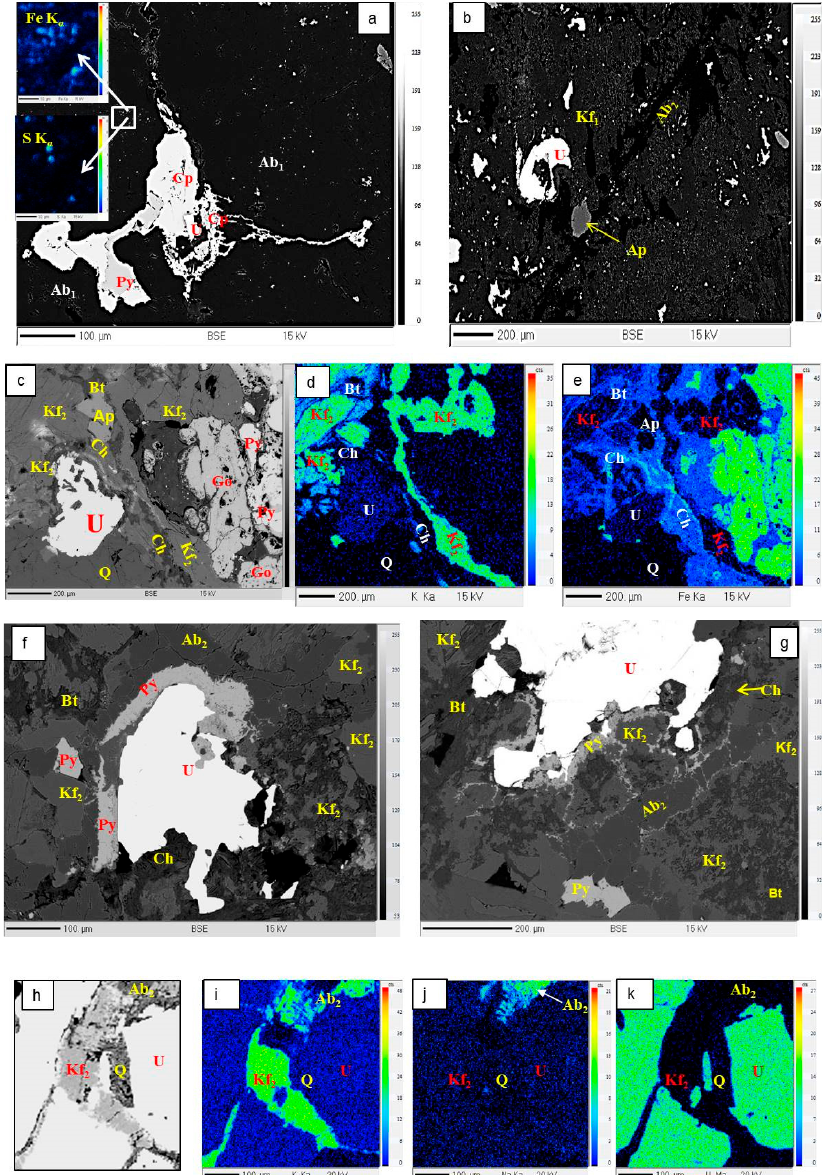
Figure 11. BSE and elemental X-ray images showing various alteration phenomena. ( a ) Aventurisa- tion of albite in close vicinity of veins containing polymetallic minerals, Fe Ka, and S Ka X-ray images (inset) indicate the presence of Fe minerals (oxide and sulphide) within nanopores of albite; ( b ) albite (Ab 2 , dark grey) replaces microcline (Kf 1 , light grey) along and also in close vicinity of microfractures; note the pitted appearance of Kf 1 due to the replacement by Ab 2 at the micron level leading to reaction-induced porosity; ( c ) biotite is altered to chlorite and K-feldspar, pyrite is altered to goethite; ( d ) elemental X-ray images of K-K α showing the occurrence of Kf 2 as small veins filling the void spaces and also as isolated grains; ( e ) elemental X-ray image of Fe-K α indicating the formation of a chlorite vein parallel to the Kf 2 vein. Uraninite (U), biotite (Bt), chlorite (Ch), pyrite (Py), and goethite (Go); ( f , g ) the occurrence of Kf 2 and Ab 2 in tandem in close vicinity to uraninite. Textural relationship between Kf 2 micro-grains and partially altered biotite provides evidence of the formation of Kf 2 at the expense of biotite; ( h ) part (rectangular box) of the BSE image in Figure 10e; K-feldspar (Kf 2 ), albite (Ab 2 ), and quartz (Q) constitute part of the vein along the interstitial space between uraninite (U) grain boundaries; ( i – k ) elemental X-ray images of Na-K α , K-K α , and U-M α of ( h ) for substantiation of the above observation. (Scale size: ( a , f , h – k ): 100 µ m, ( b – e ) and ( g ): 200 µ